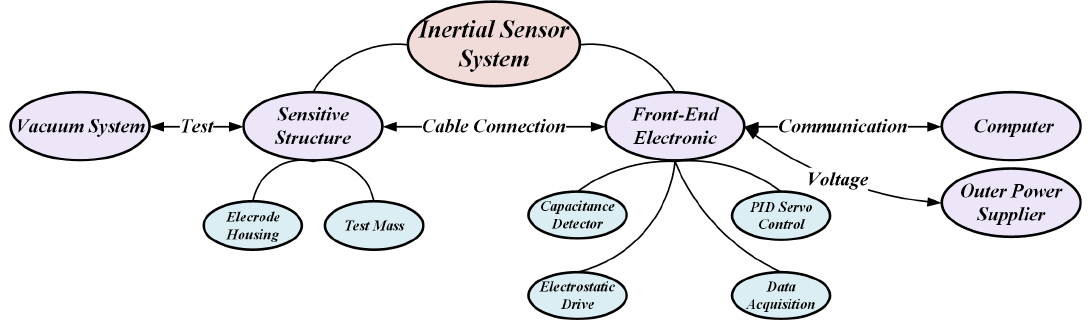
Figure 1. Schematic structure of the inertial sensor (IS) system.